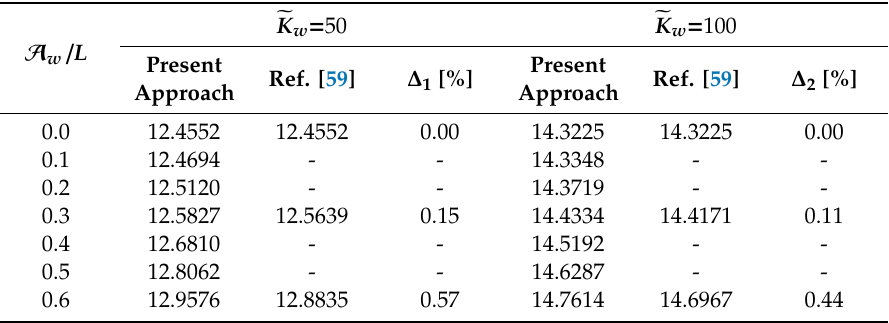
Nonlocal dimensionless natural frequencies of a homogeneous clamped-clamped (C-C) nano-beam resting on an elastic foundation for various dimensionless amplitude